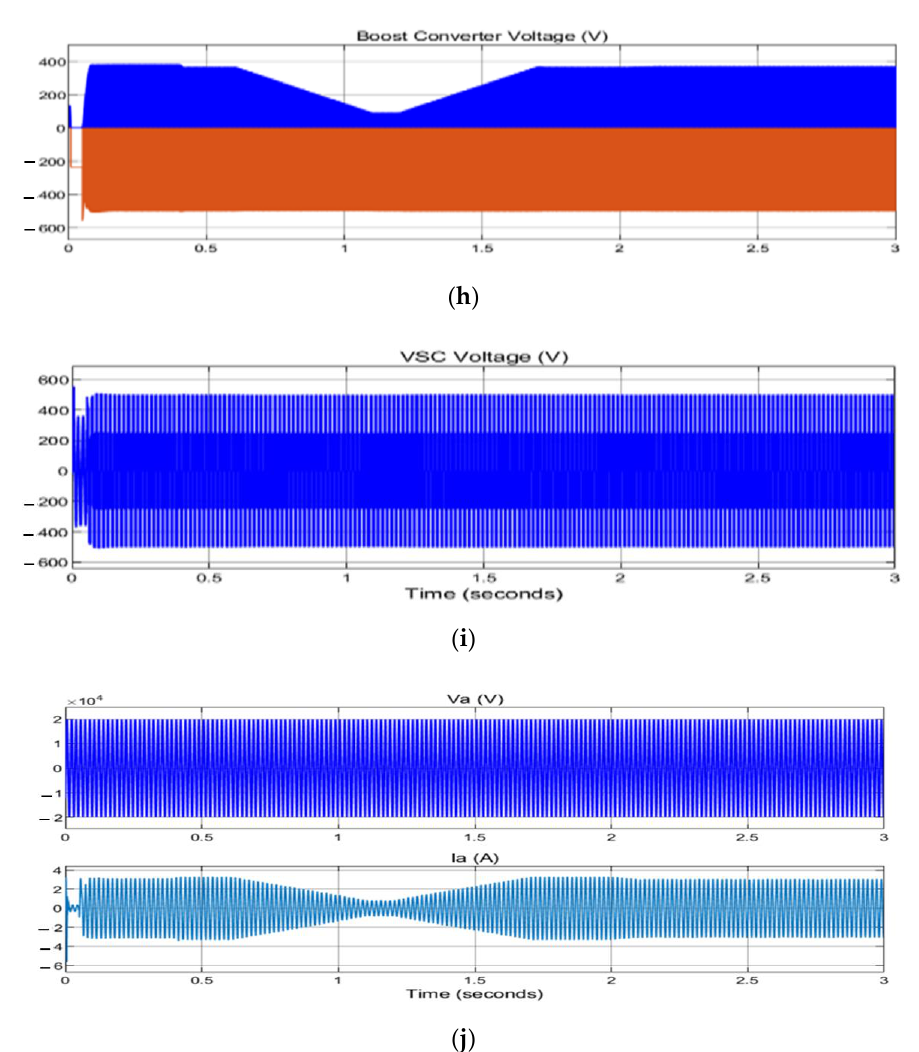
Figure 10. ( a ) Change in the sun irradiance; ( b ) change in the temperature; ( c ) duty cycle; ( d ) grid and solar output power; ( e ) solar output voltage; ( f ) incremental conductance algorithm tracking the PPP ; ( g ) error minimized by the application of the integral regulator scheme; ( h ) boost converter; ( i ) VSC voltage; ( j ) grid voltage and current.